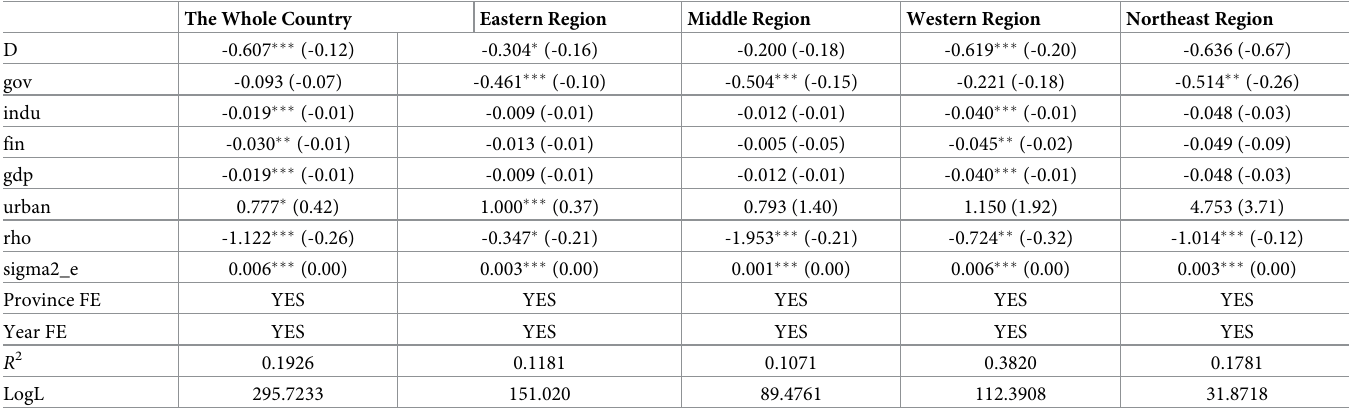
Table 5. Model estimation results. The Whole